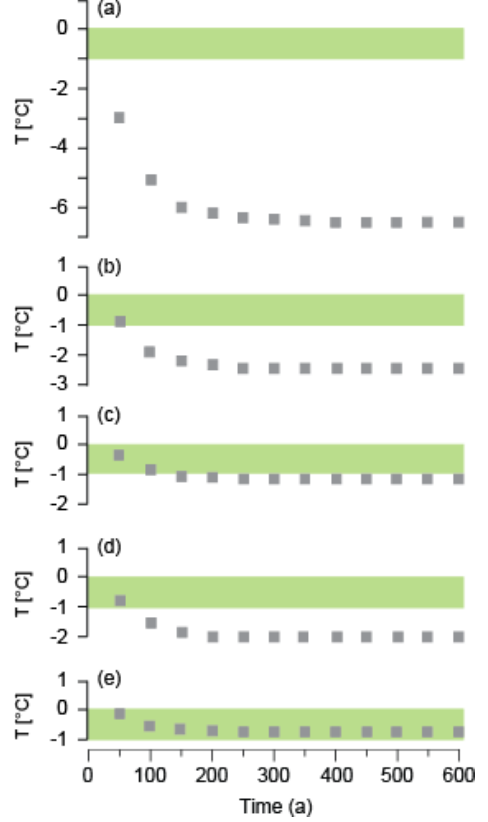
Figure 3. Thermal models 2a to 2e simulating the development and deepening of the permafrost during the early YD. Modelling results depict the ground temperature at 50m of depth at the depth of the CCC site in Cioccherloch. These models use the temperature pro- file of scenario 1 as an initial condition. Model 2a (a) is forced with a MAAT of − 6 . 5 ◦ C. Models 2b (b) and 2c (c) use a MAAT of − 2 . 5 ◦ C, and the latter simulates the impact of winter snow cover, resulting in the attenuation of the winter cold by 5 ◦ C (i.e. snow (cid:49)T = 5 ◦ C). Scenarios 2d (d) and 2e (e) model the changes in the thermal profile at the CCC site using a MAAT of − 1 . 5 ◦ C. Scenario 2e considers the presence of a winter snow pack, resulting in snow (cid:49)T of 4.7 ◦ C. The green horizontal bar marks the − 1 to 0 ◦ C “win- dow” of possible CCC formation for the depth range of the CCC site in this cave.